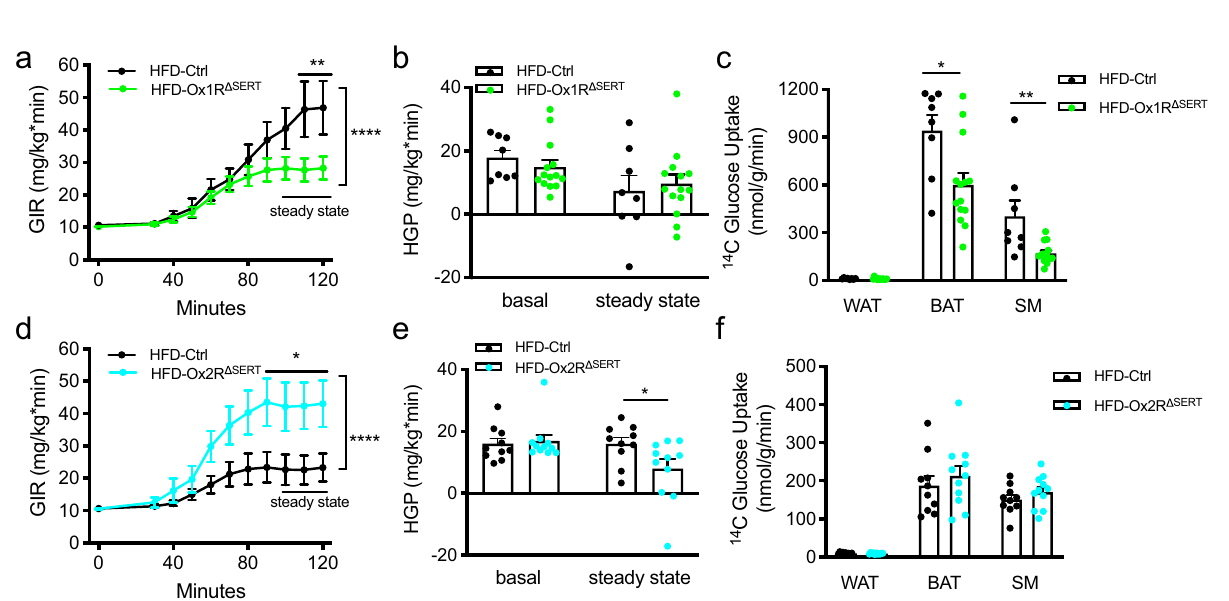
Fig. 4 Increased c-Fos activation in orexin neurons upon high-fat diet (HFD) feeding and improved glucose tolerance in Ox2R Δ SERT mice fed a HFD. a Representative images of RNAscope in situ hybridization in the lateral hypothalamus (LH) of a BL/6 mouse fed a control diet (CD) or HFD. n = 5 (CD) and 4 (HFD). b Percentages of c-Fos positive neurons in orexin neurons. n = 5 (CD) and 4 (HFD). p = 0.029. c , g Average body weight, glucose tolerance test under d , h 16-h and e , i 6-h fasting conditions, and f , j insulin tolerance test of control (Ctrl) and Ox1R Δ SERT mice on normal chow diet (NCD) or HFD. NCD- Ctrl and NCD-Ox1R Δ SERT , n = 9; HFD-Ctrl, n = 8 ( g , h , j ) or 11 ( i ); HFD-Ox1R Δ SERT , n = 10 ( g , h , j ) or 12 ( i ). i p = 0.16 at 30 min. k , o Average body weight, glucose tolerance test under l , p 16-h and m , q 6-h fasting conditions, and n , r insulin tolerance test of Ctrl and Ox2R Δ SERT mice on NCD or HFD. NCD-Ctrl, n = 11; NCD-Ox2R Δ SERT , n = 8; HFD-Ctrl, n = 11 ( o , p , r ) or 13 ( q ); HFD-Ox2R Δ SERT , n = 9. p p = 0.0002 (30 min) and 0.045 (60 min); q p = 0.076 (30 min). Magenta, orexin; yellow, c-Fos. Scale bar: 100 µ m. Data are represented as means ± SEM. * p < 0.05, ** p < 0.01, *** p < 0.001; as determined by unpaired two-tailed Student ’ s t -test ( b ) or two-way ANOVA followed by Sidak ’ s post hoc test ( i , p , q ). Two-way ANOVA revealed a signi fi cant main effect of genotype in ( i ) ( F (1, 105) = 7.86, p = 0.0060), p ( F (1, 90) = 18.22, p < 0.0001) and q ( F (1, 100) = 6.08, p = 0.015). Source data are provided as a Source Data fi le.